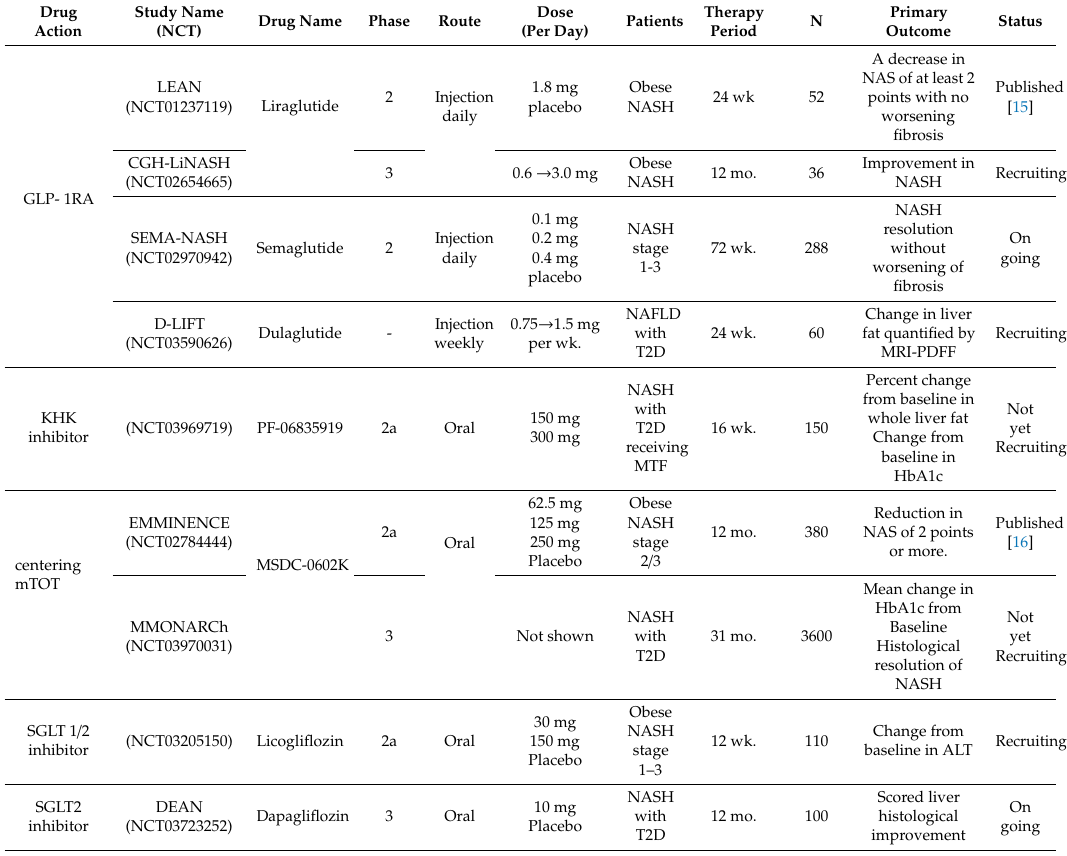
Table 1. Antidiabetic drugs for nonalcoholic steatohepatitis (NASH) under development. Drug